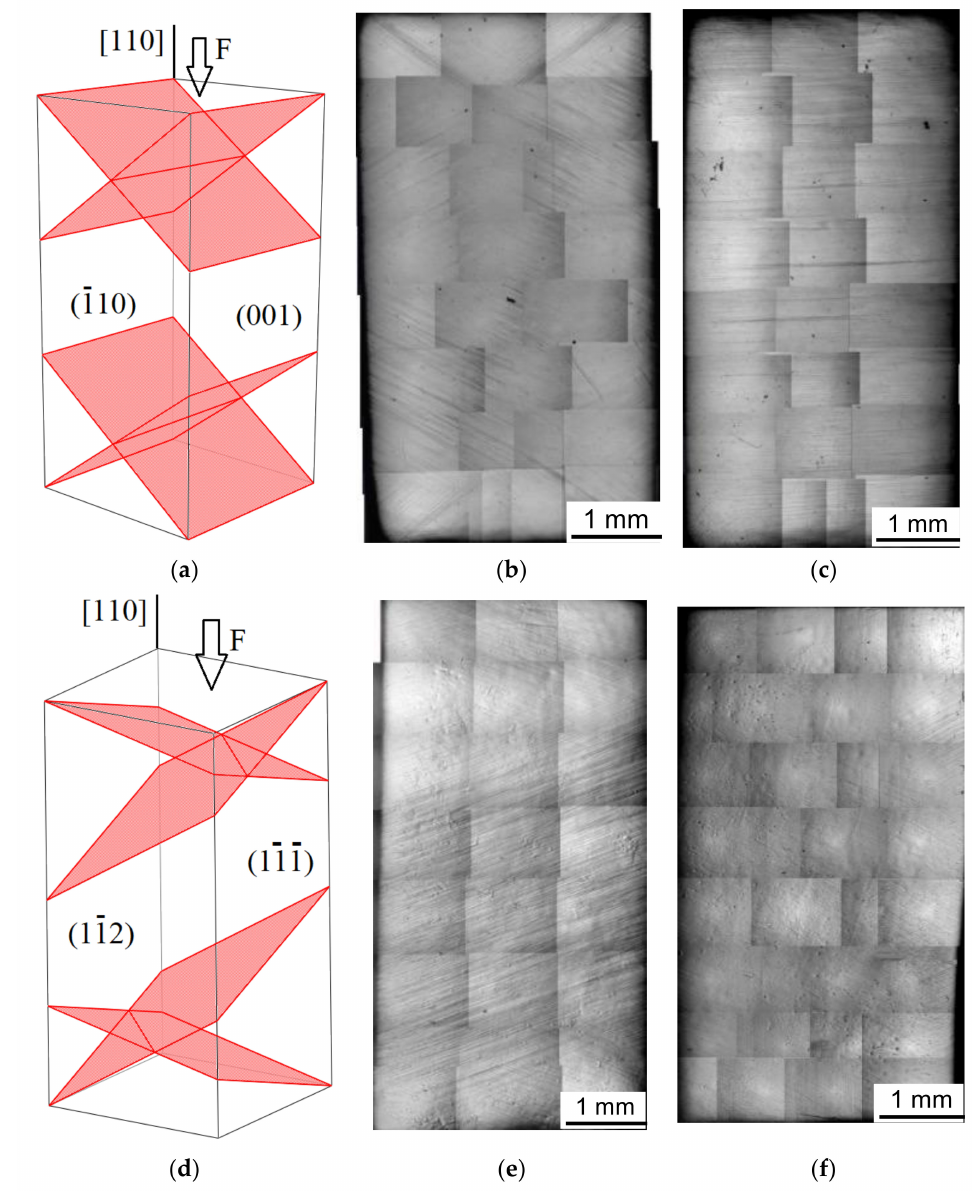
(cid:0) (cid:1) (cid:0) (cid:1) (cid:0) (cid:1) 110 and (001) ( a – c ) or 112 and 111 lateral faces ( d – f ) com- (cid:0) (cid:1) (cid:0) (cid:1) (cid:0) (cid:1) 110 ( b ), (001) ( c ), 112 ( e ), 111 ( f ) lateral faces at ε =